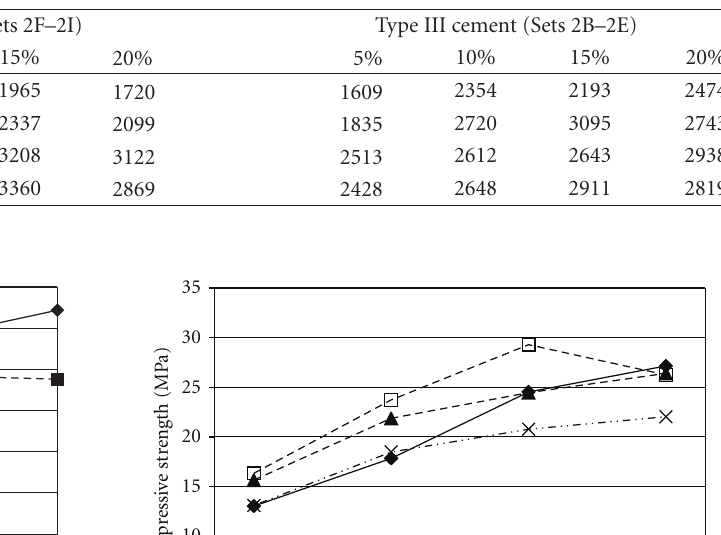
Table 5: Modulus of elasticity for di ff erent types of cement, testing ages and percents of cement added (MPa).